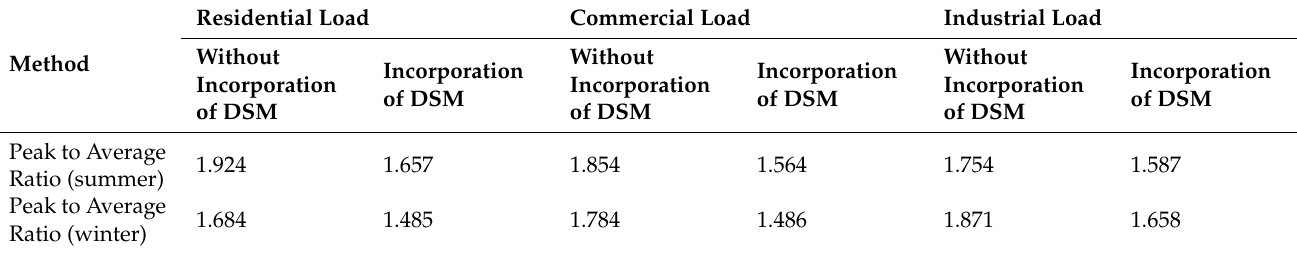
Table 12. Peak to Average Ratio